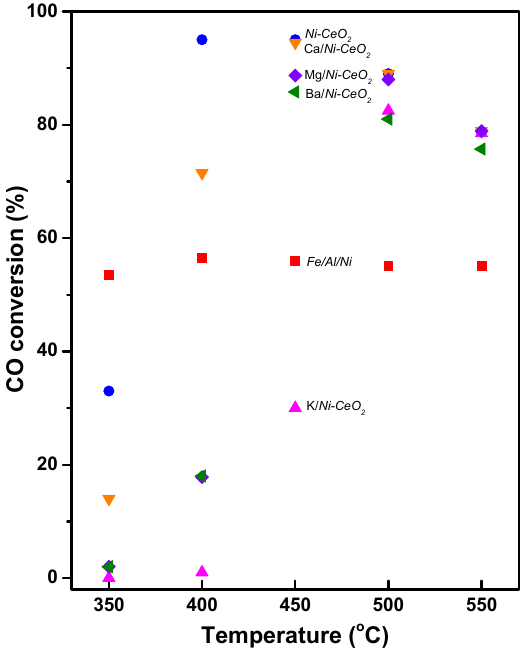
Figure 7. CO conversion of Ni-based catalysts.